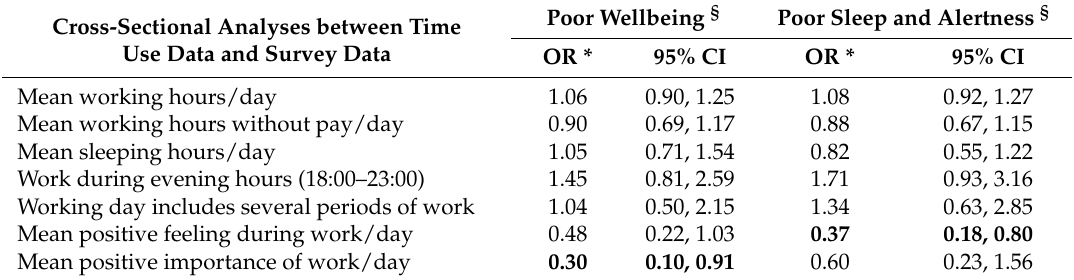
Table 3. Odds ratios (OR) with 95% confidence intervals (CI) for associations between time use and wellbeing and sleep in expert